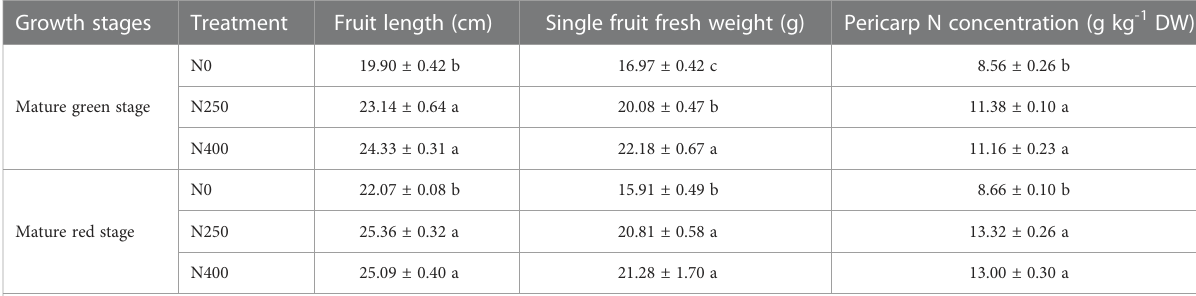
Values (means ± SE, n = 4) followed by different letters indicate signi fi cant difference between N application levels at the same growth stage at P < 0.05 according to the Duncan ’ s multiple range test. DW, dry